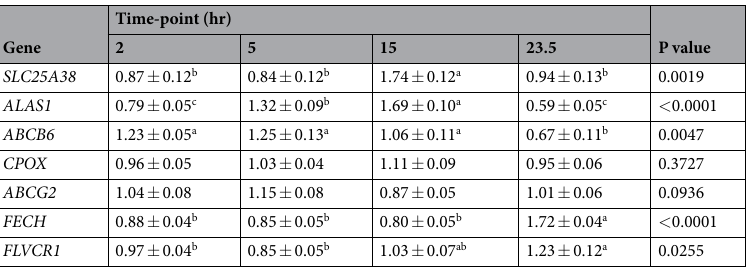
Table 1. Relative expression levels of candidate target genes involved in the synthesis of protoporphyrin IX and/ or heme at different time-points of eggshell formation in the shell gland of laying hens. Values are the mean of normalized relative quantities (NRQ) ± standard error. Relative quantities for individual gene are scaled to the average across all unknown samples per target gene. Different superscript letters a,b,c across a row denote significantly different